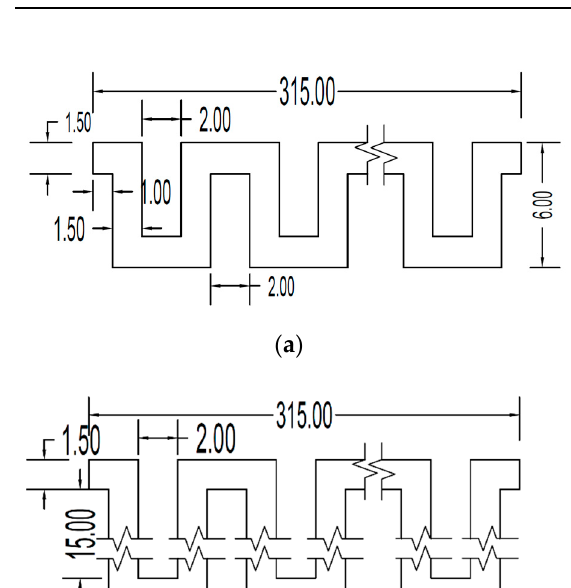
Figure 1. Dimensions of emitters (mm). ( a ) Dimensions of A emitter; ( b ) Dimensions of D emitter.